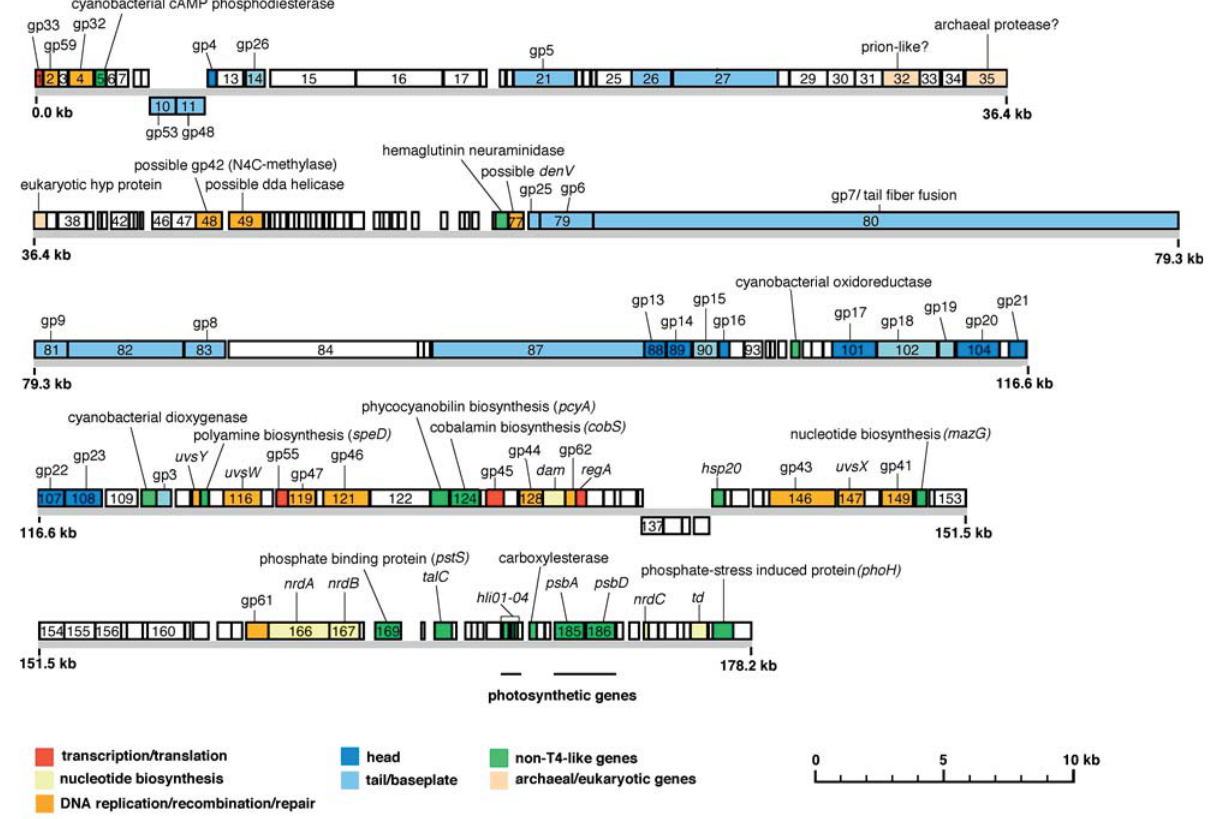
Figure 4. Genome Arrangement of the Prochlorococcus Myovirus P-SSM4.